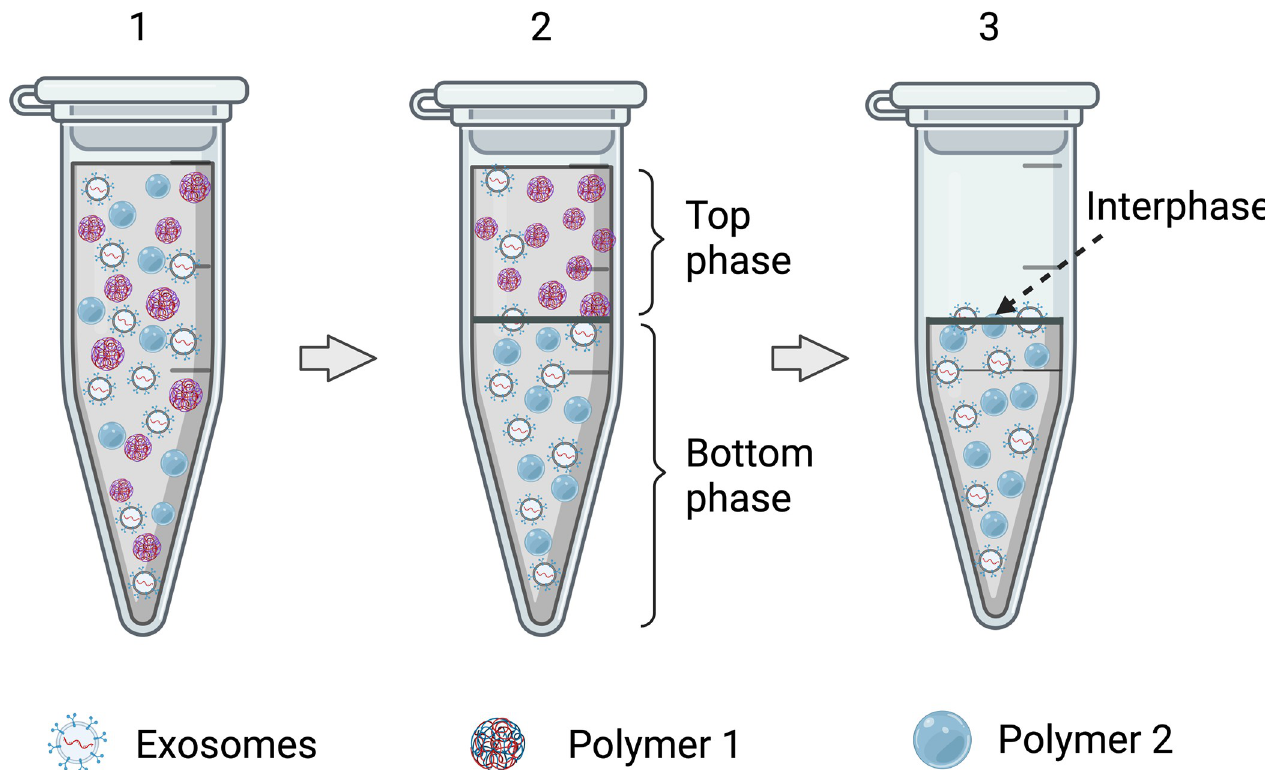
Fig 1. Key steps in the ATPS exosome purification process. 1) Mixture of polymer solutions and samples (i.e., exosomes or contaminants separately); 2) phases formation and exosome separation after vortex and centrifugation steps; 3) recovery of top phase composed mainly of polymer 1 for further quantification of isolated samples. The protein recovery yield for the exosomes and contaminant samples was estimated for both phases, considering the interphase as part of the bottom phase composed of mainly of polymer 2. Figure created using Biorender.com.